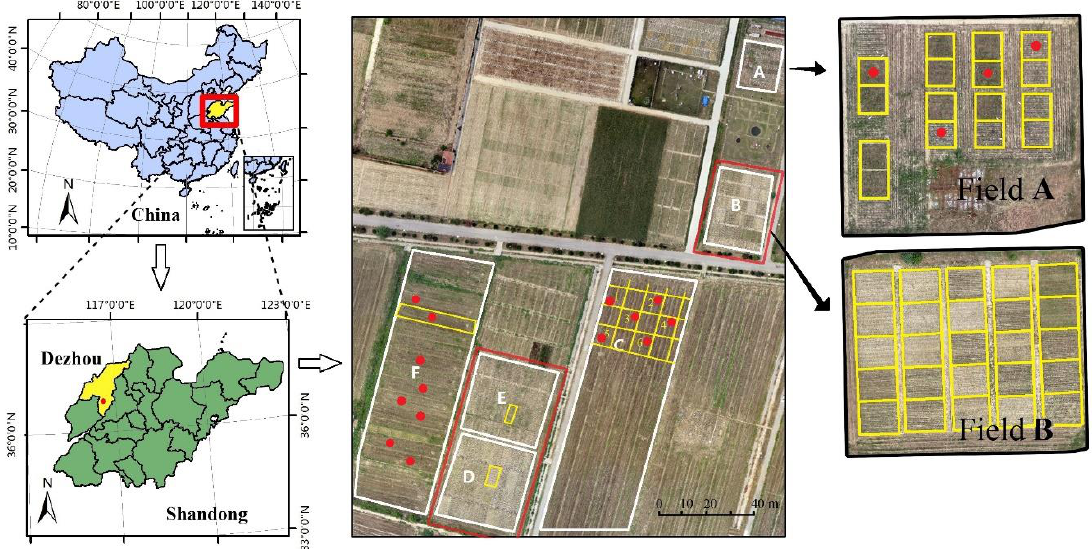
Figure 1. Location of Yucheng Comprehensive Experiment Station (YCES) and overview of the long-term experimental plots. (The yellow rectangles are the boundaries of plots. The red rectangles are flight coverage of the UAV hyperspectral mission; two UAV multispectral missions covered all six fields. The red spots are ground sampling plots for Fields A, C, and F in 2018). Table 2. Treatments of the six experimental fields.